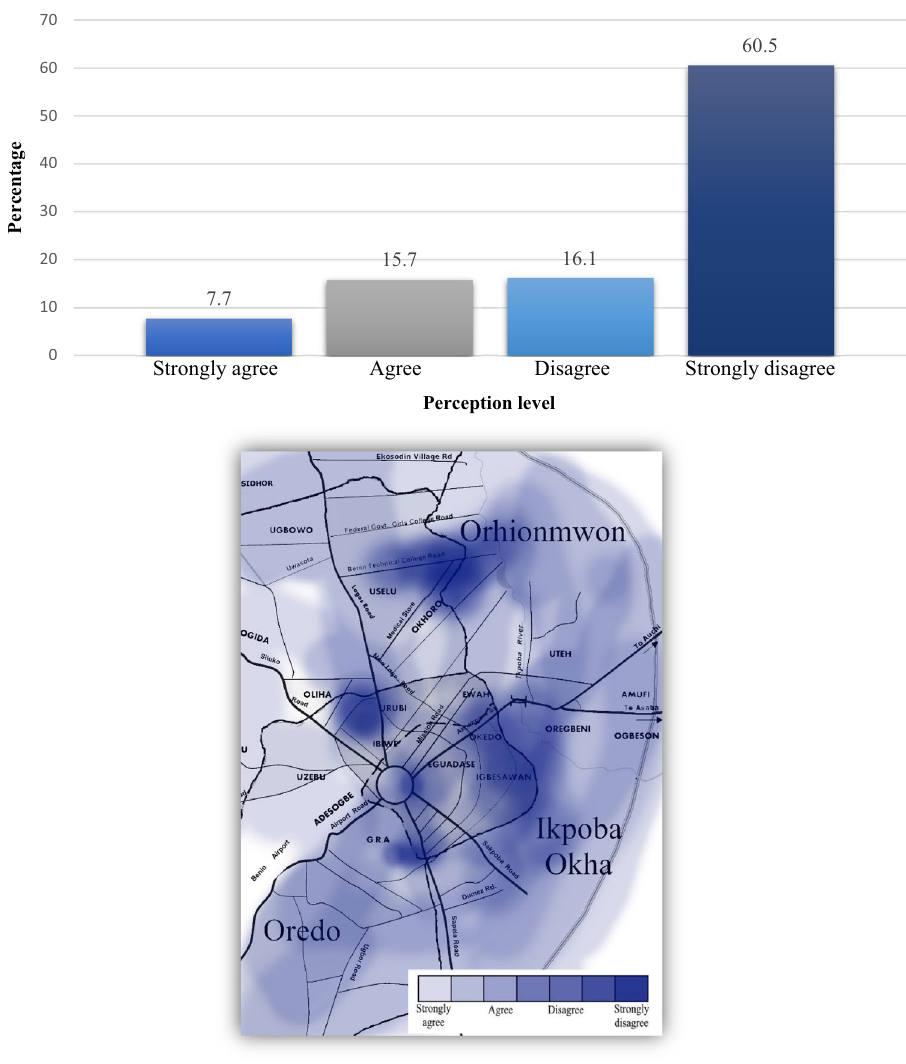
Figure 1. Perception of whether GHG emission techniques and methods used by the government adequately create awareness about the health implications of MSW in Benin City: (top) graph, (bottom) mapped